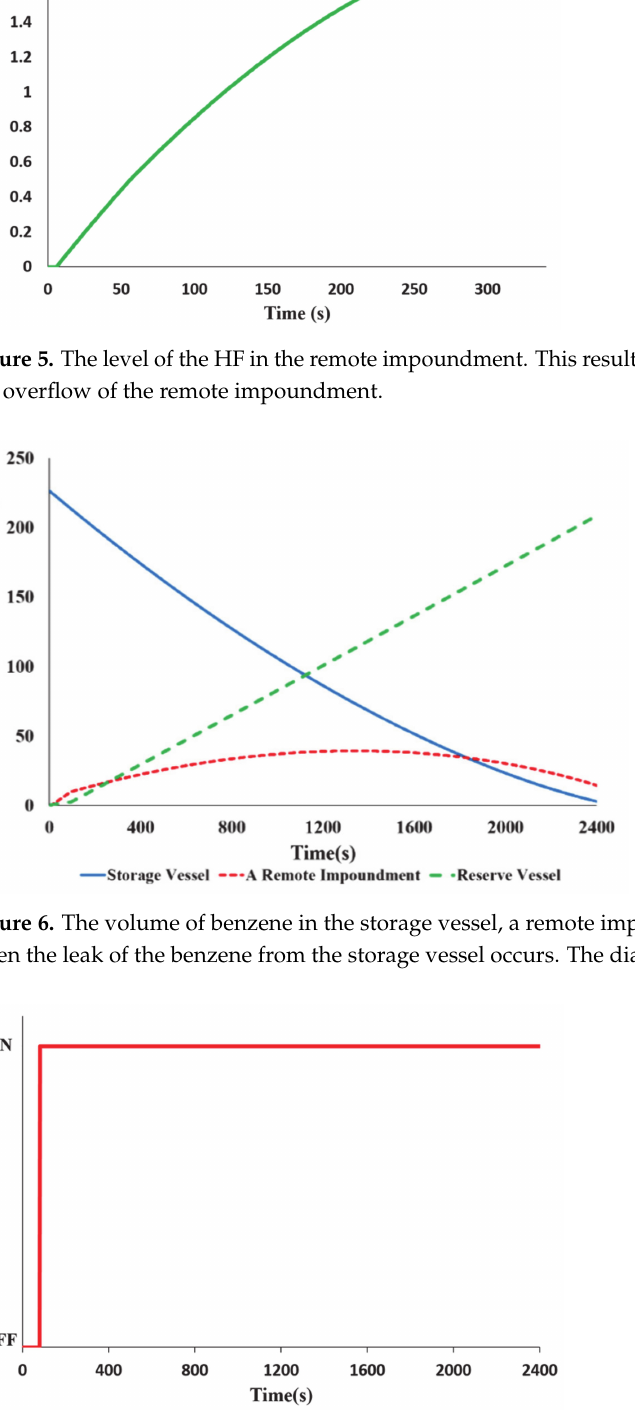
Figure 7. The operation of Pump 2 when the pump capacity is 238 m 3